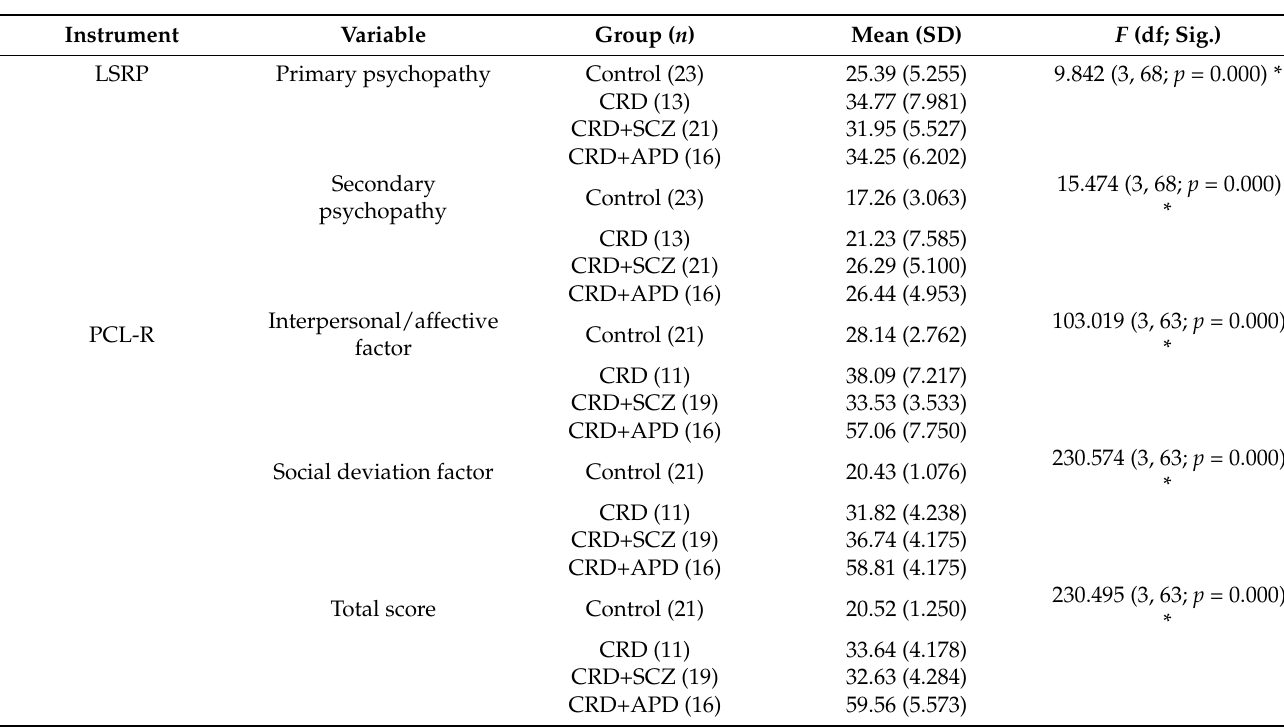
Table 3. Scores and comparisons between the groups for the following dependent variables: impulsivity, activation, behavioral inhibition, and psychopathy.